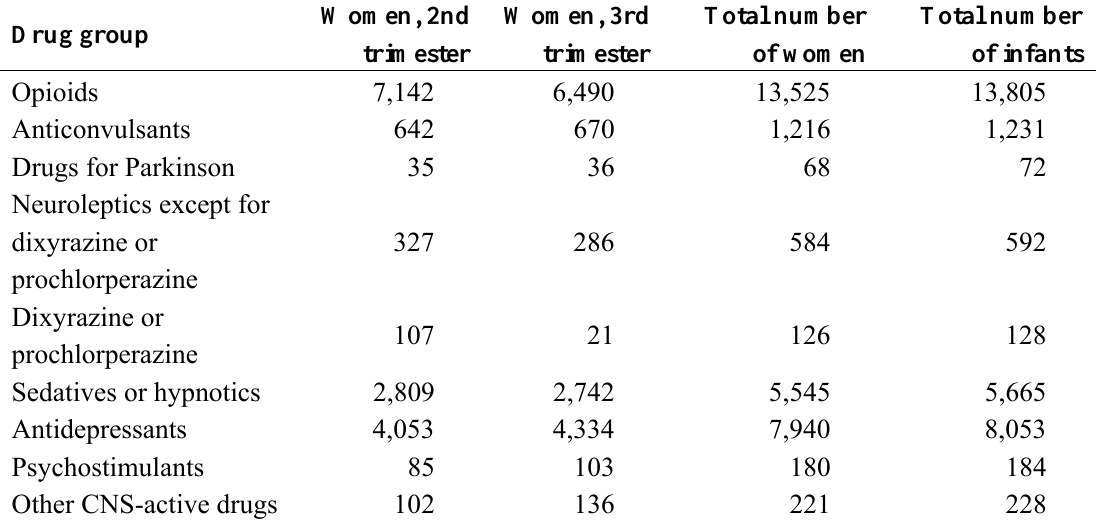
Table 6. Number of women filling prescriptions for various CNS active drugs during the 2nd or 3rd trimester and their